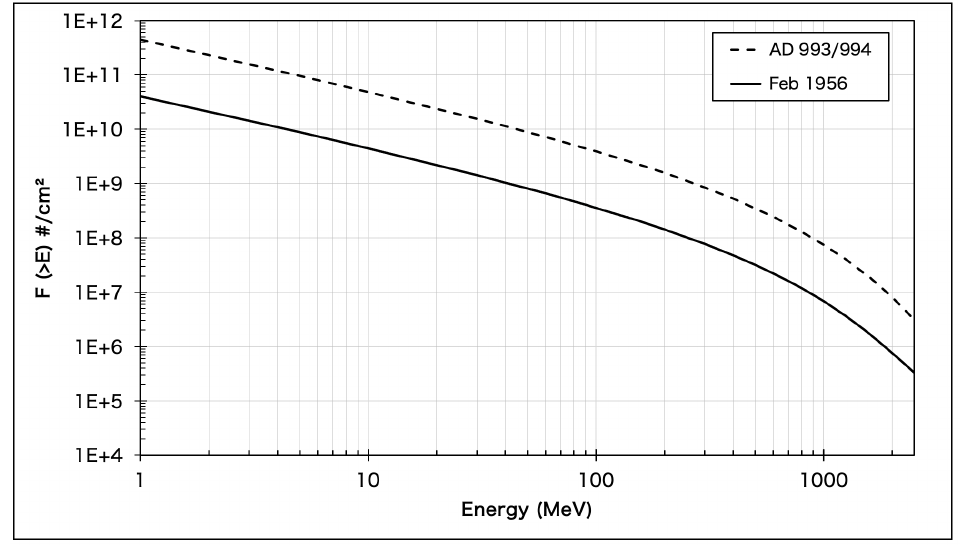
Figure 1. Proton fluence spectra for the February 1956 SPE based on [13] and the scaled AD 993/4 SPE used in this